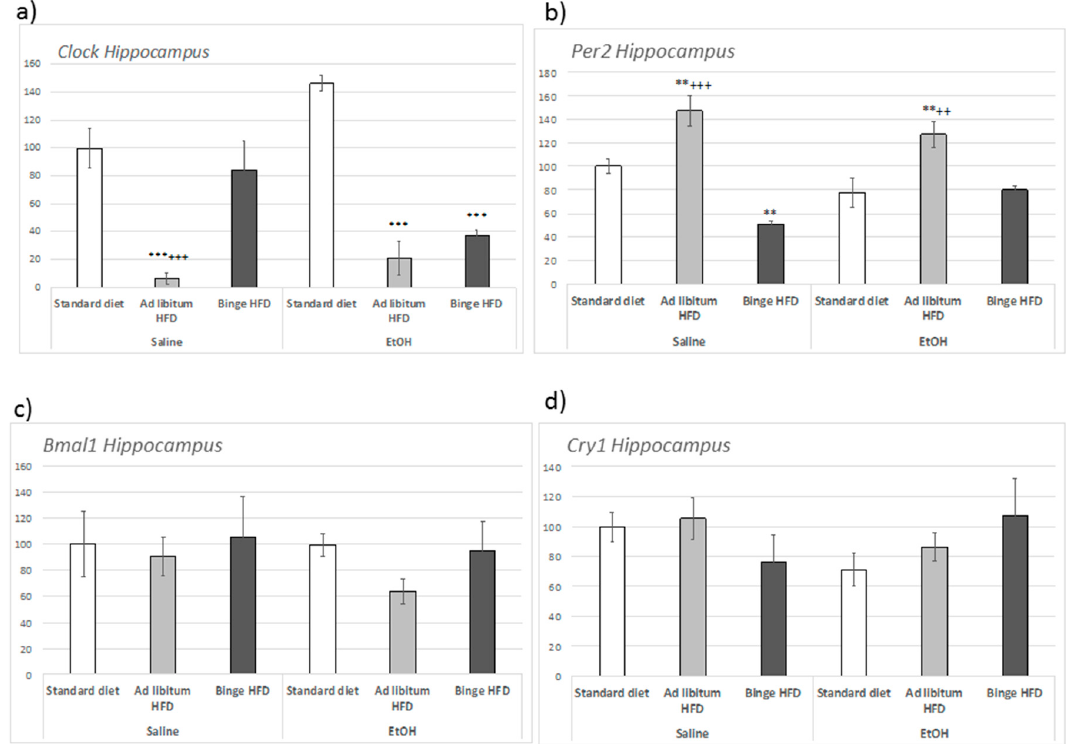
Figure 5. Effect of an ad libitum or binge HFD exposure and EtOH binge on adolescent mice in the circadian gene expression in the hippocampus. ( a ) Clock ; ( b ) Per2 ; ( c ) Bmal1; ( d ) Cry1 . Data are presented as mean ( ± SEM) *** p < 0.001; ** p < 0.01 with respect to the standard diet; +++ p < 0.001; ++ p < 0.01 with respect to the binge